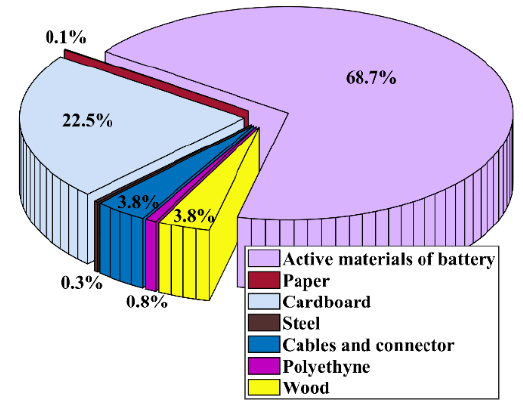
Figure 21. Percentage of different material content in lead acid batteries, with the active material comprising the major portion [74].